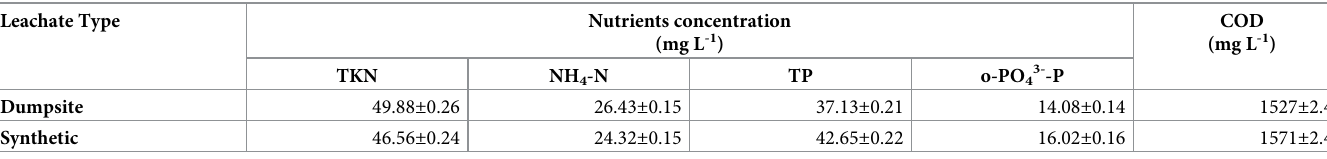
Table 1. Initial nutritive composition and COD (mean ± SD) of leachate used as media for duckweed growth. Leachate